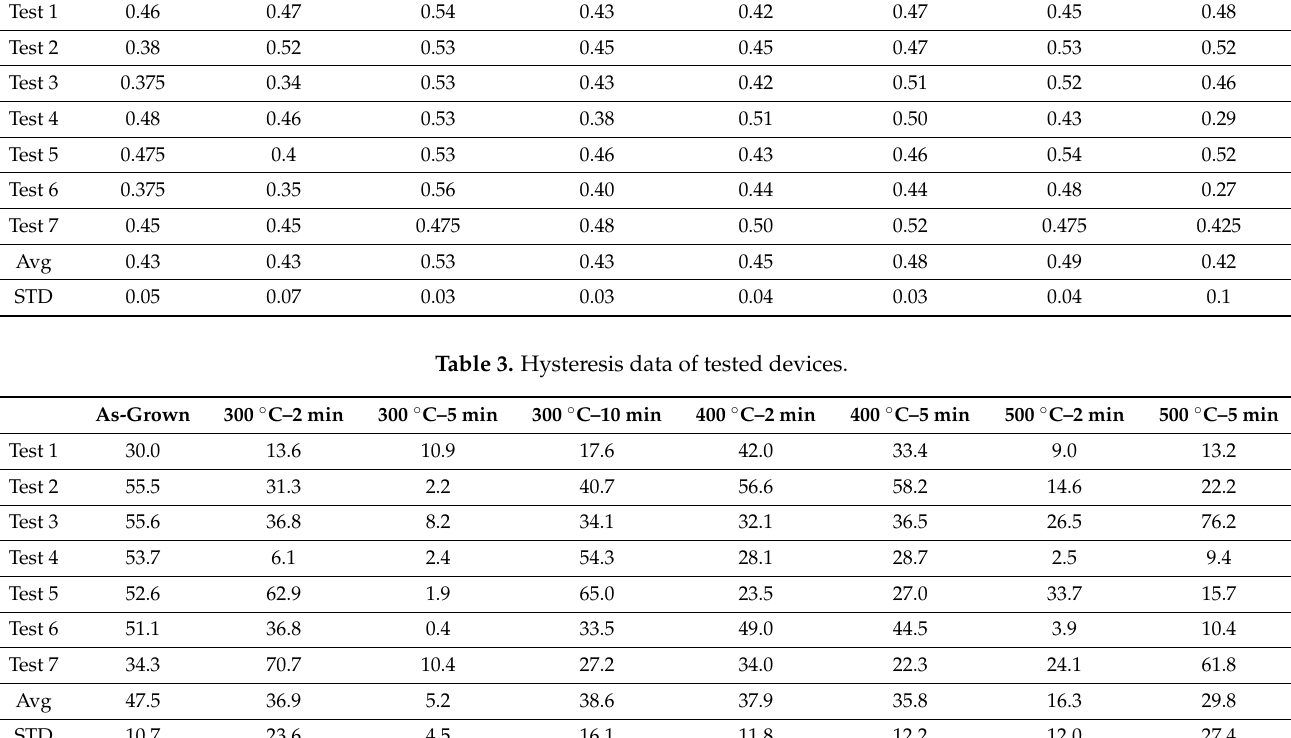
where A is the area of the measured device, q the electron charge, G p the parallel conduc- tance, and ω the angular frequency. [26] The D it values of the as-grown, 300 ◦ C–2